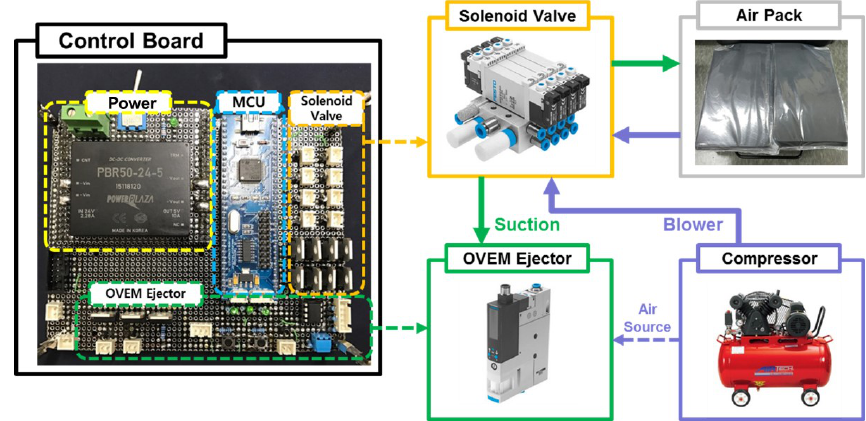
Figure 4. Configuration of the pneumatic system.